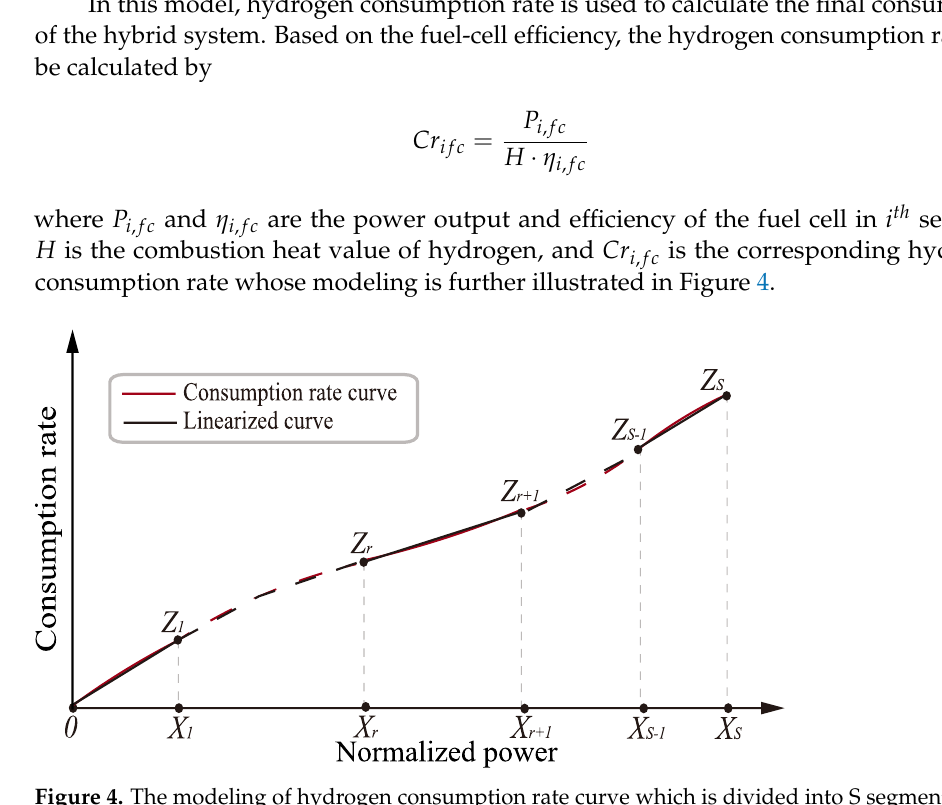
Figure 4. The modeling of hydrogen consumption rate curve which is divided into S segments. X r is the normalized power of the fuel cell and Z r is the corresponding hydrogen consumption